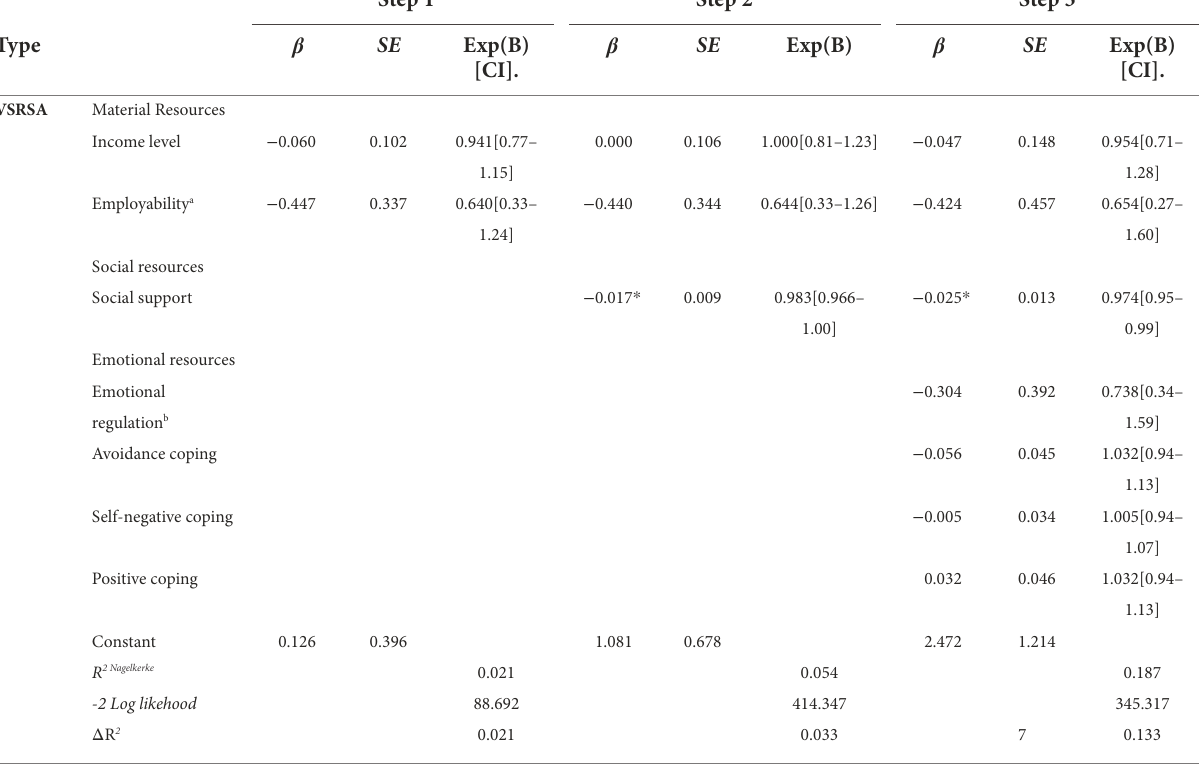
TABLE 5 Hierarchical multinomial logistic regression using VSR as reference